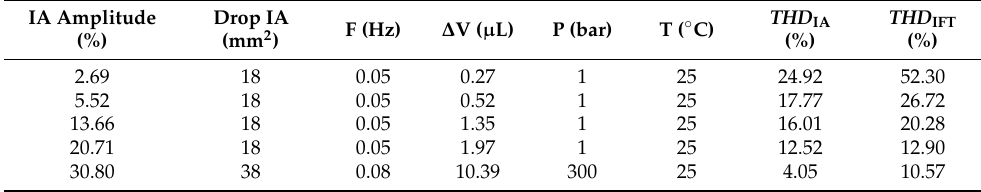
Table 2. Effect of the amplitude on sinusoidal signal fitting.